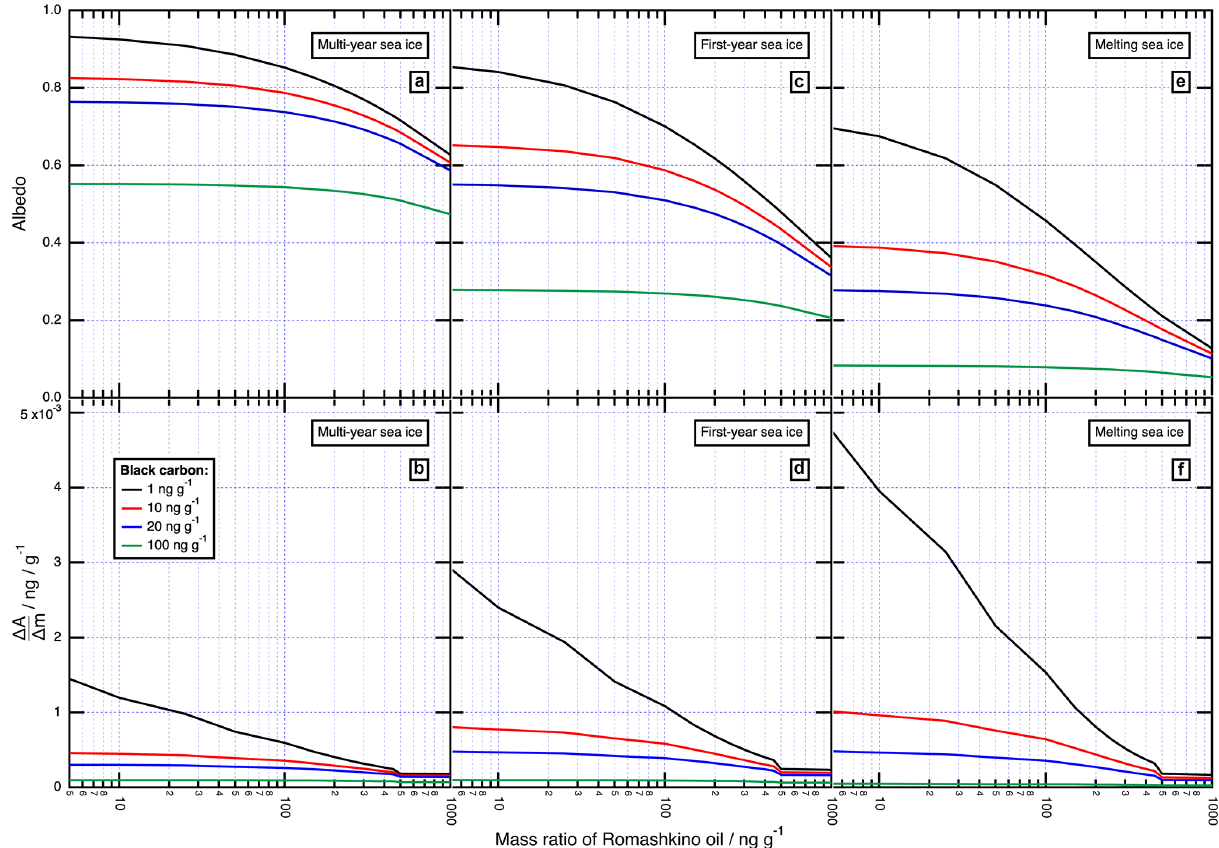
Figure 5. Albedos of multi-year (a) , first-year (c) , and melting (e) sea ice with increasing mass ratios of Romashkino oil (0–1000ngg − 1 ) with a peak droplet radius of 0.05µm. The gradients ( (cid:49)A ) of plots (a) , (c) , and (e) are shown for multi-year (b) , first-year (d) , and melting (f) (cid:49)M sea ice, respectively. The selected wavelength is 400nm, and the background levels of black carbon increase as follows: 1ngg − 1 (black line), 10ngg − 1 (red line), 20ngg − 1 (blue line), and 100ngg − 1 (green line). The three types of sea ice are quasi-infinite, and their properties are described in Table 1. These data demonstrate that increasing mass ratios of black carbon rapidly decrease the albedo response of each type of sea ice to Romashkino